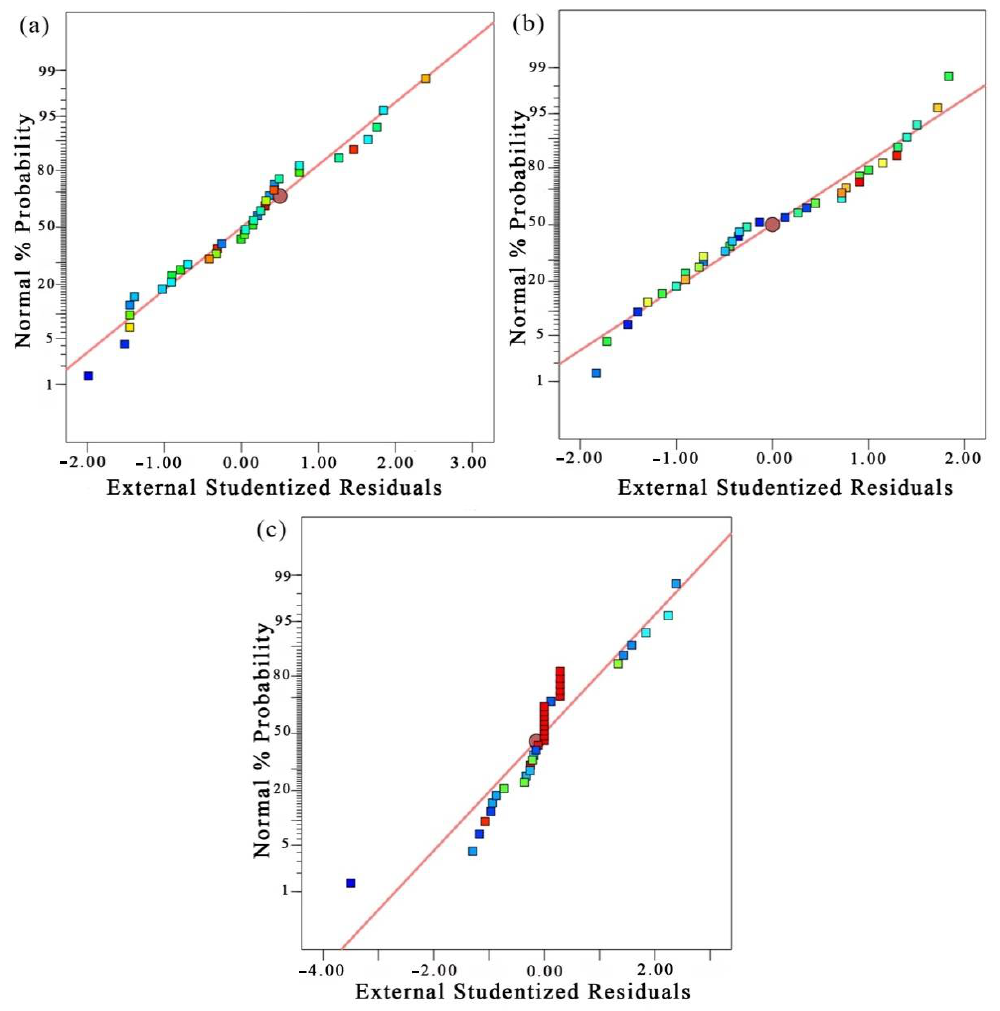
Figure 4. Normal plot of residual for ( a ) elastic modulus, ( b ) hardness, and ( c ) weight loss.